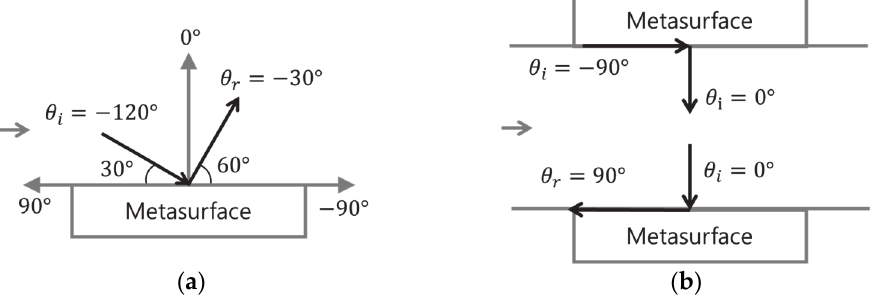
Figure 5. Incident angle and reflection angle setting: ( a ) example; ( b ) U-shaped refraction. Table 1. Design dimensions of the metasurface derived using generalized Snell’s law.